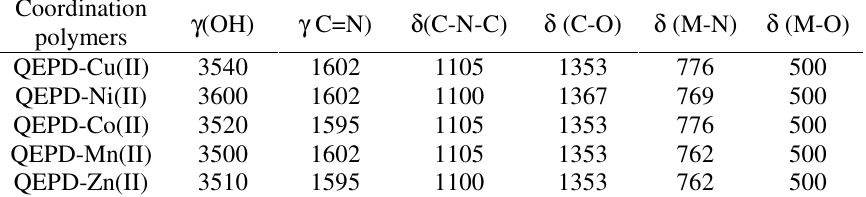
Table 4. Infrared frequencies (cm -1 ) of QEPD coordination